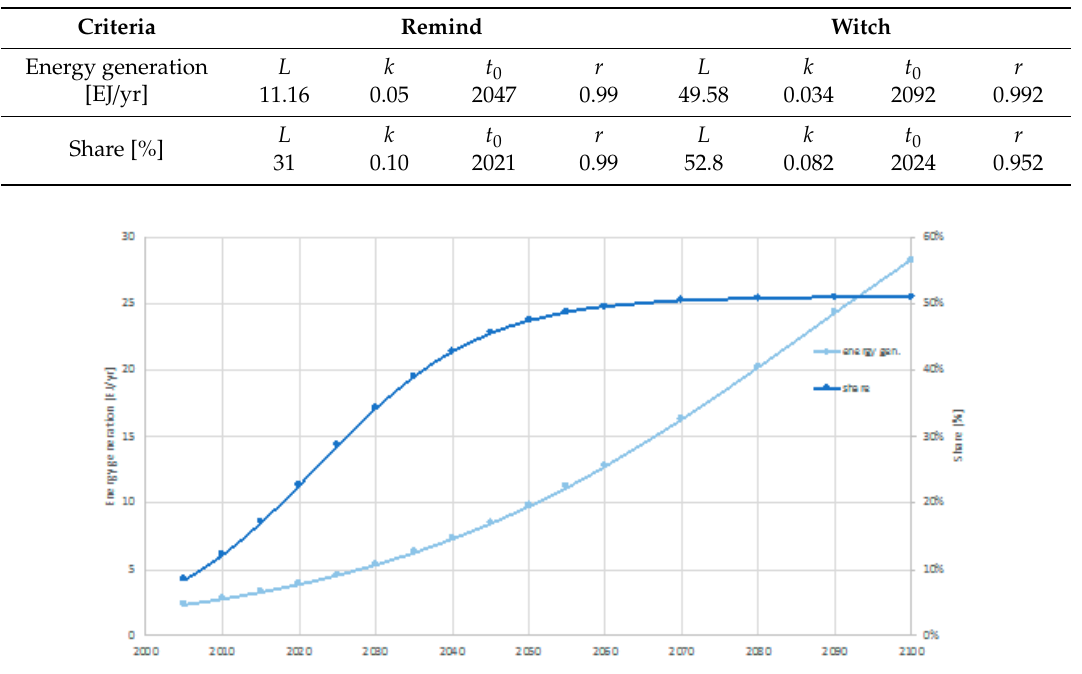
Figure 9. Europe Wind technology energy generation development based on Reference Scenario of REMIND until year 2100 (own work). Table 9. Parameters calculated for the S-shaped wind technology curves (Figures 9 and 10).